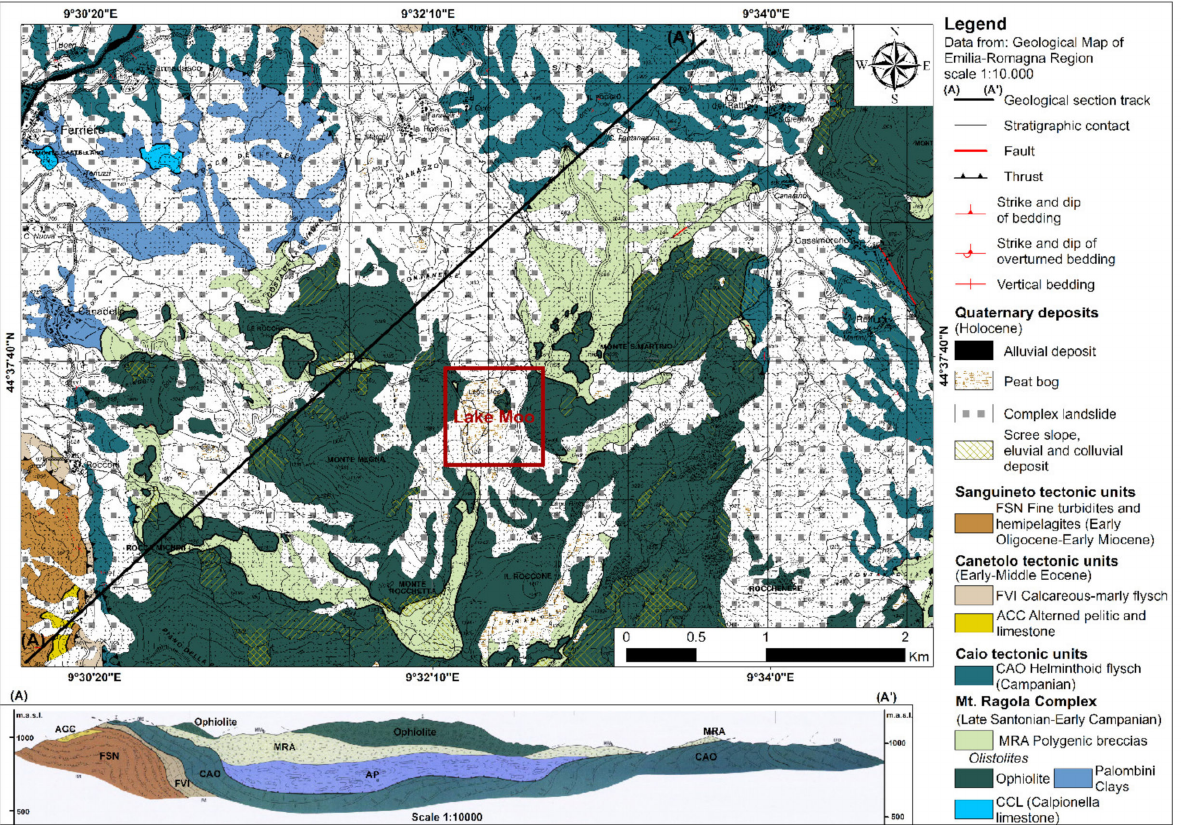
Figure 3. Map and geological cross-section of the Mt. Ragola ophiolitic massif with location of the study area. Modified from [11].